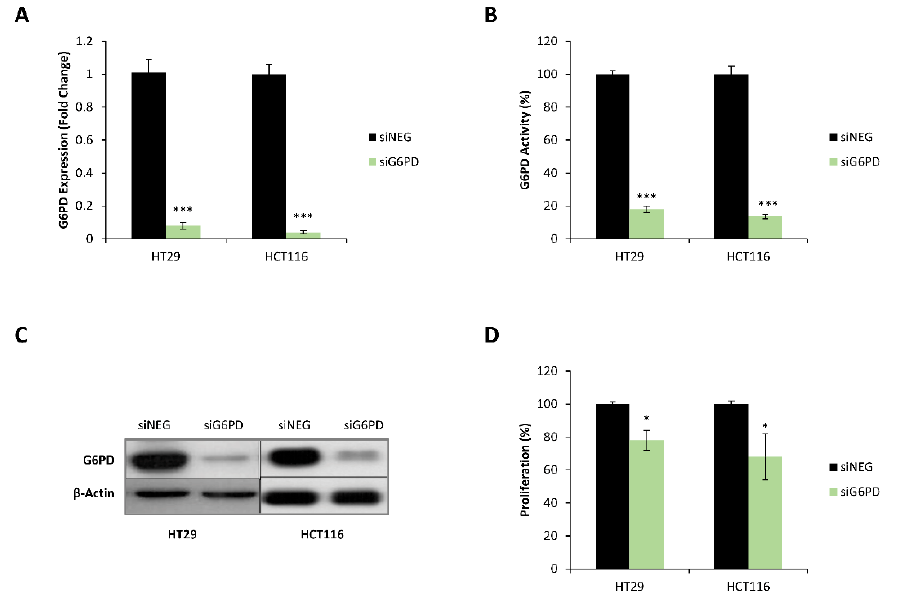
Figure 2. G6PD knockdown caused the inhibition of G6PD activity and reduced the proliferation of colon cancer cells. ( A ) G6PD mRNA expression 72 h after transfection with non-targeting siRNA pool (siNEG) or siRNA pool against G6PD. Fold change was calculated with respect to cells transfected with the siNEG pool. ( B ) Total G6PD enzyme activity normalized to intracellular protein content measured 96 h after transfection using either non-targeting siRNA pool or siRNA pool against G6PD. Fold change was quantified relative to cells transfected with the siNEG pool. ( C ) G6PD protein levels 96 h post-transfection using either non-targeting siRNA pool or siRNA pool against G6PD. ( D ) Effect of G6PD knockdown on cell proliferation measured by flow cytometry 120 h after transfection for G6PD-inhibited cells and cells transfected with siNEG pool. Fold change was quantified relative to cells transfected with the siNEG pool. One asterisk (*) denotes p -value < 0.05, three asterisks (***) denote p -value < 0.001.